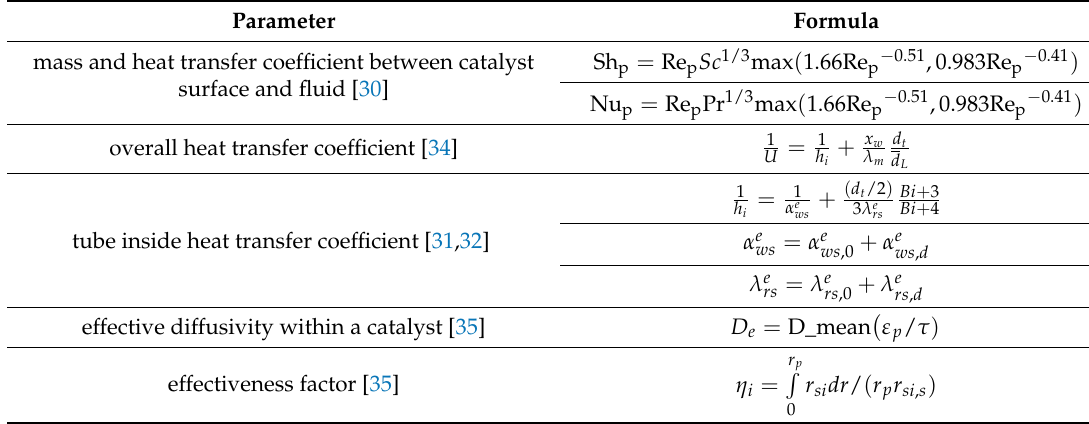
Table 4. Correlations and equations used for the 1D heterogeneous model.